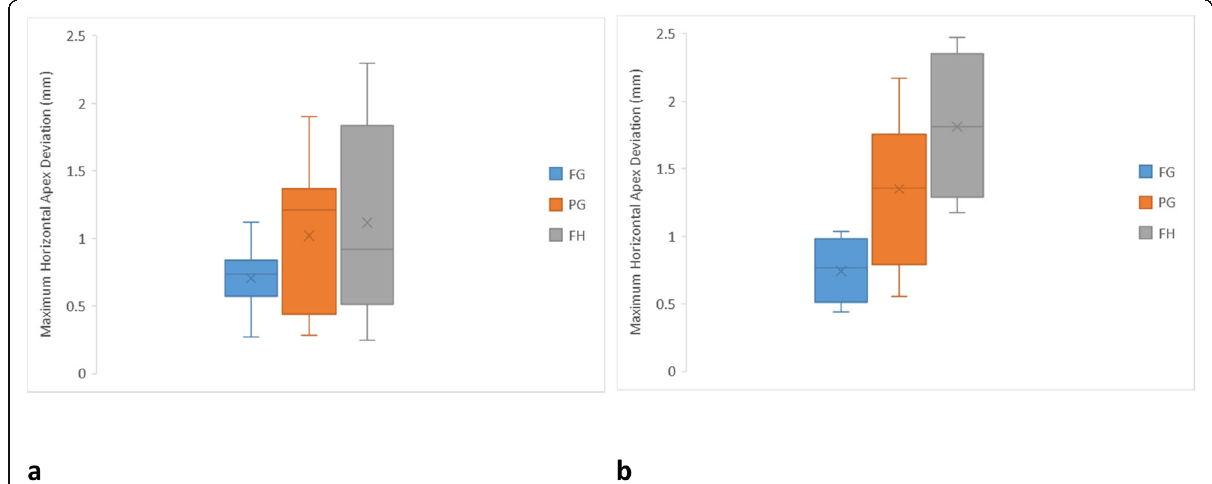
Fig. 6 Box plot diagrams illustrating the distribution of maximum horizontal apex deviation of each protocol. a Anterior implants. b Posterior